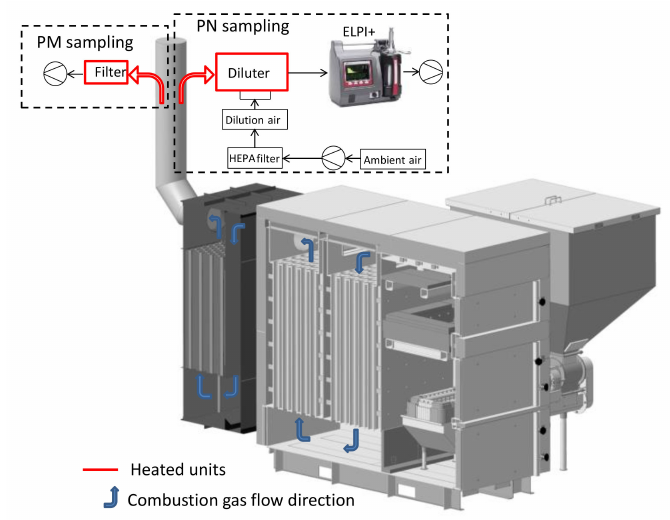
Figure 1. The experimental setup.